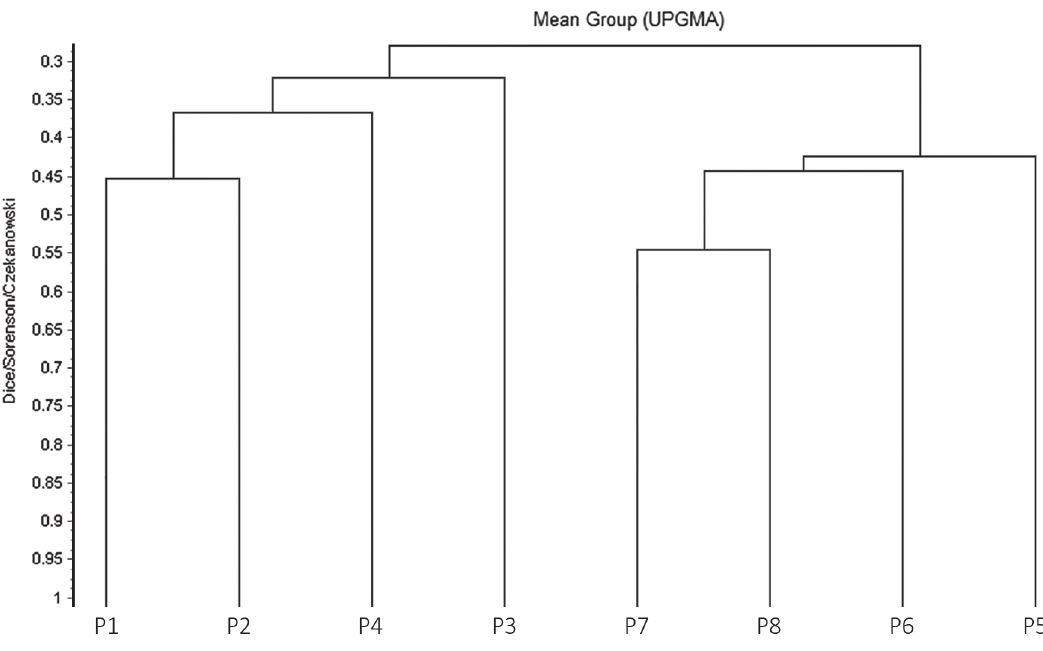
Figure 2 - Climatic diagram (2000 to 2010) built from the data obtained from the Center for Meteorological Analyses of the University for the Development of the State and of Pantanal Region (Universidade Anhanguera-UNIDERP), Mato Grosso do Sul,